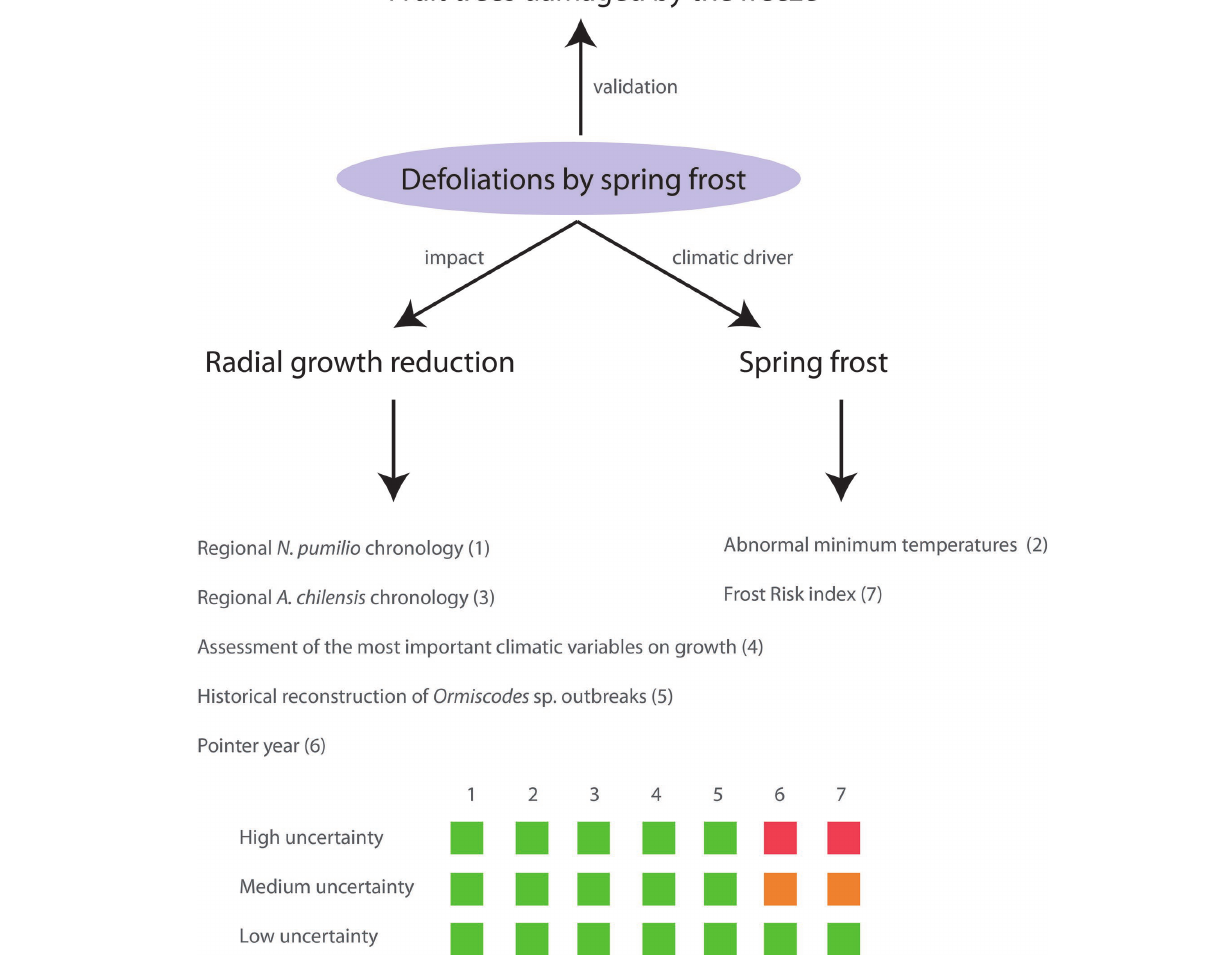
Frontiers in Plant Science |